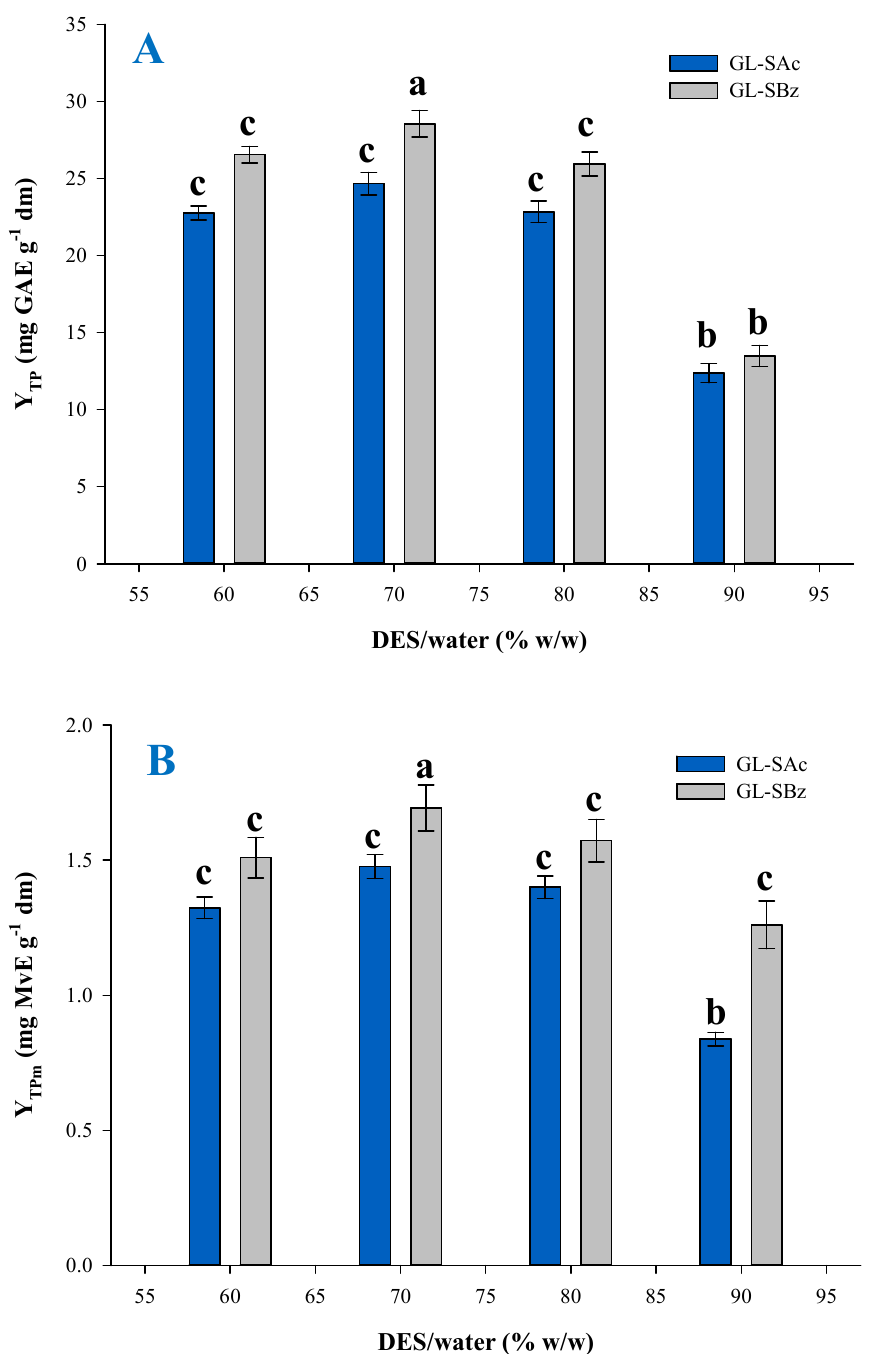
Figure 1. The effect of water proportion on the yield in total polyphenols (Y TP ) ( A ) and total pigments (Y TPm ) ( B ). Extractions were carried out at 50 °C and 500 rpm, with R L/S = 20 mL g − 1 for 150 min. Letters a, b and c signify statistical difference ( p < 0.05).